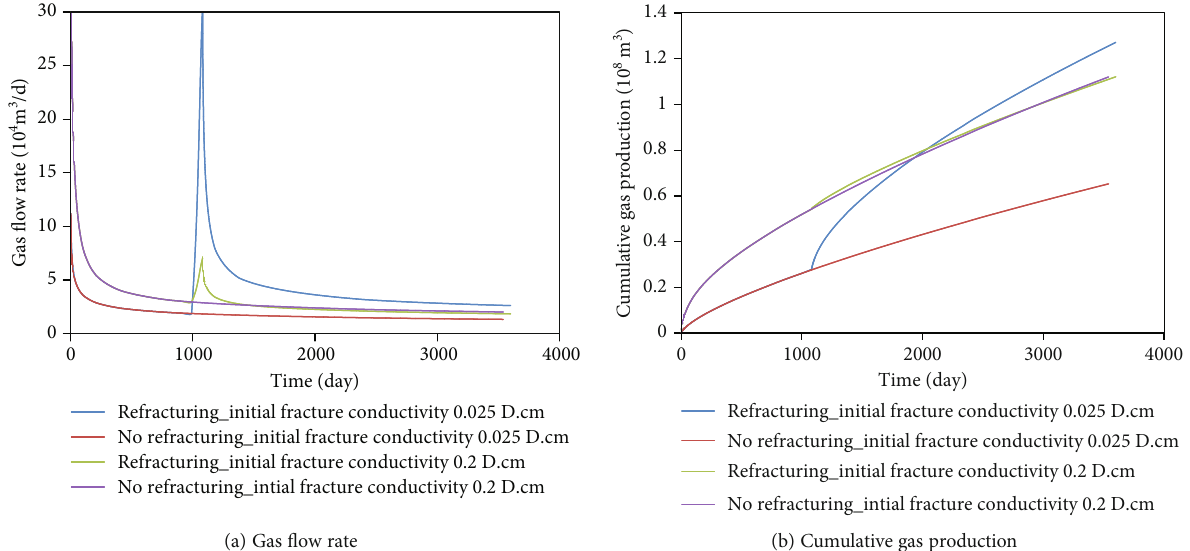
Figure 13: In fl uence of initial fracture conductivity on refracturing production.